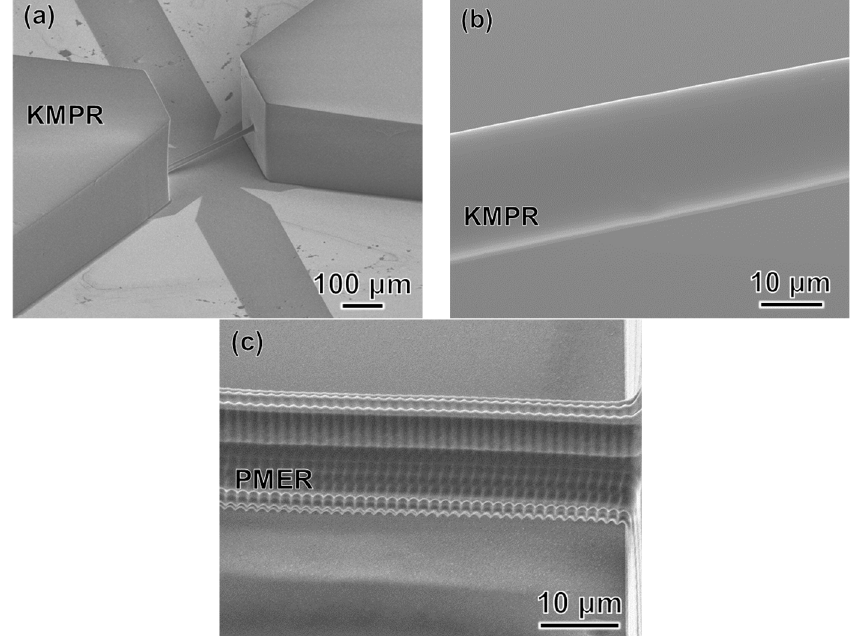
Figure 11. SEM images of the mold fabricated using FMEx: ( a ) Low magnification; ( b ) High magnification with a chemically amplified resist (KMPR); ( c ) High magnification with a standard resist (PMER).